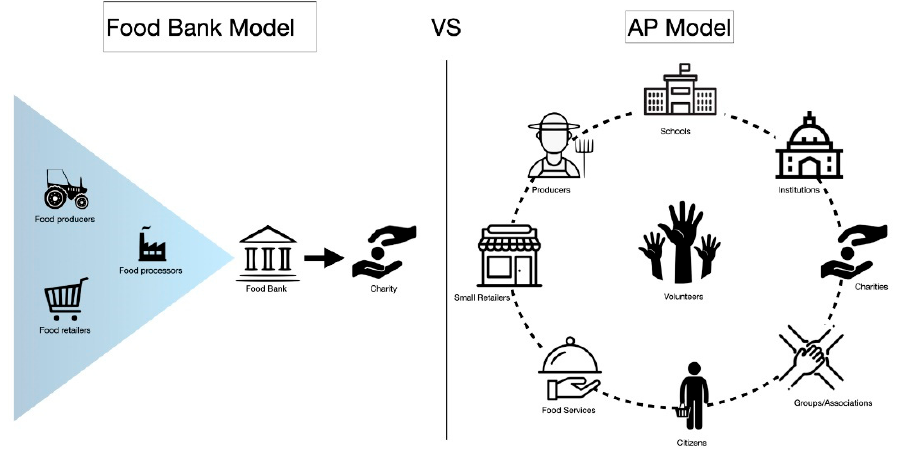
Figure 5. Traditional SI model vs AP model. Source: own elaboration.